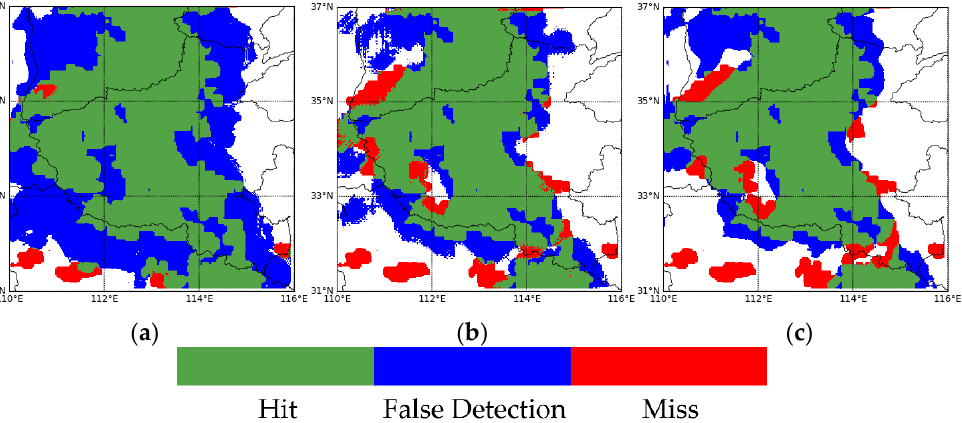
Figure 8. Visualization of precipitation identification performance of Unet, PERSIANN-CNN and Attention-Unet model over the Henan province at 0430 UTC 19 July 2021. ( a ) Unet; ( b ) PERSIANN- CNN; ( c ) Attention-Unet.